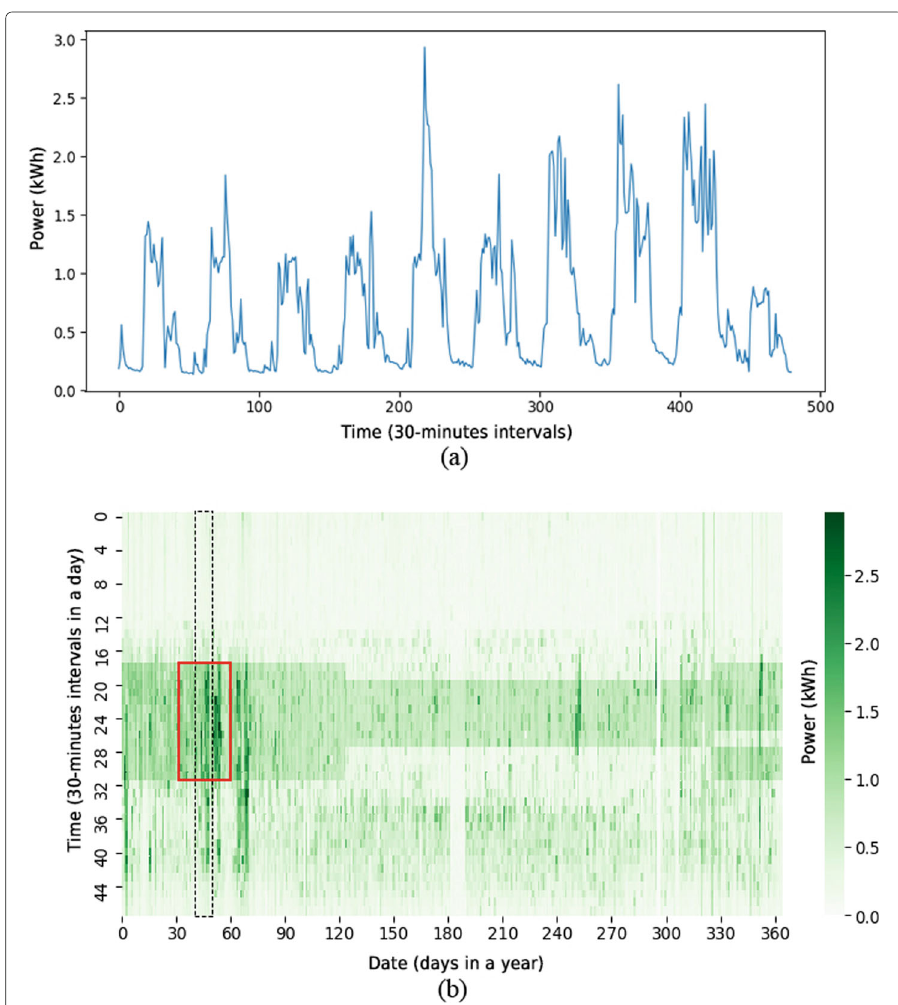
Fig. 1 Energy consumption data visualization. a The time-series representation of 10 days in June. b The matrix representation of the whole year. The data inside the dashed line boundary from (b) is the matrix representation of the same data in ( a ). The red rectangle in ( b ) is the period from 10 am to 2pm on every day in